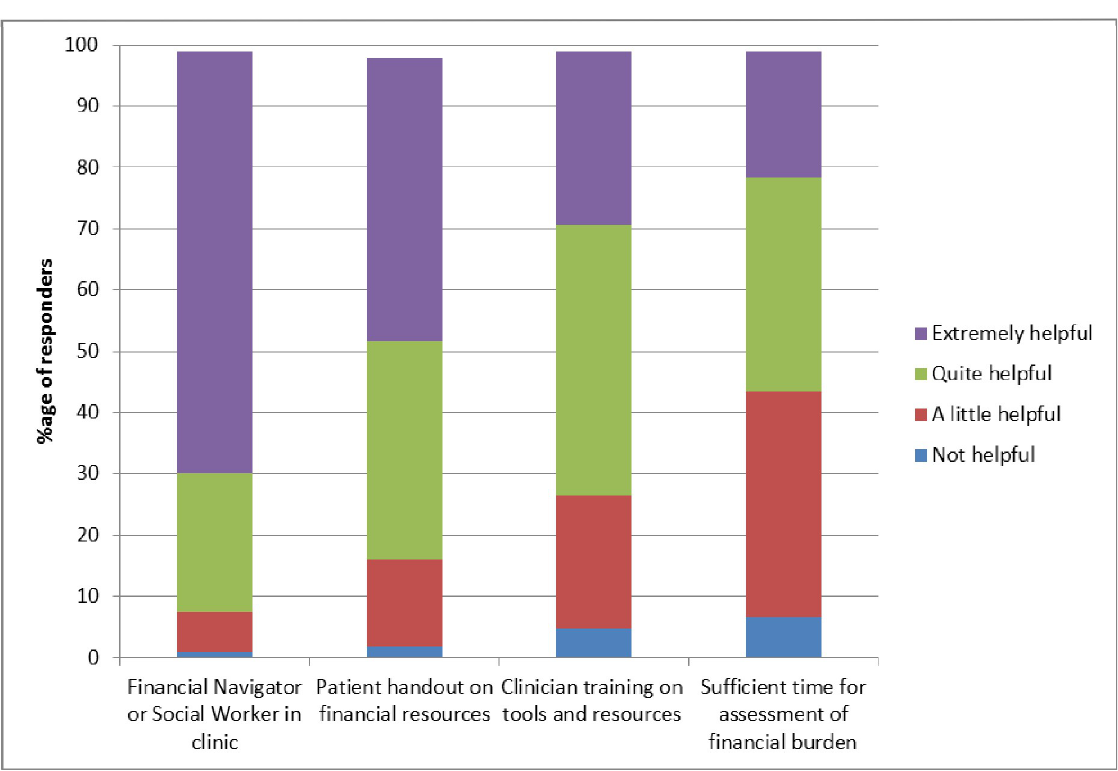
Fig 7. Oncologists’ views on tools to assist in management of financial burden in the